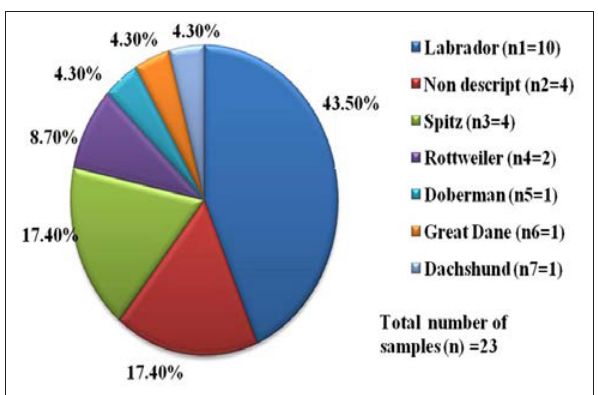
Figure-3: Breed wise analysis of positive samples.